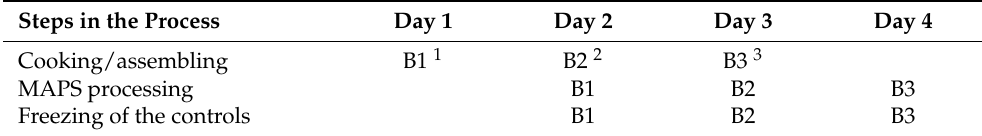
Table 2. Preparation and processing schedule of the three batches of jambalaya used in the